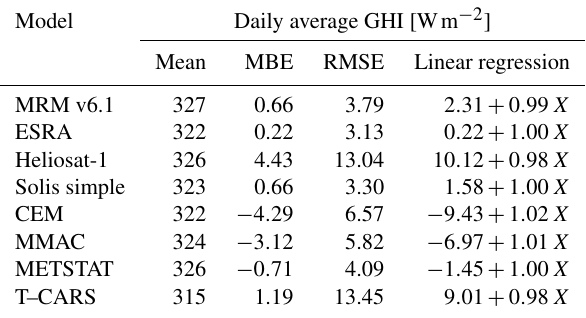
Table 4. Comparison of the annual mean of daily average values of GHI at the surface simulated with each CSM and T–CARS com- pared to DWD observations. Note that the number of days available for comparison varies between models. In addition to MBE, RMSE and correlation ( R ), the linear regression function is shown with ref- erence irradiance measured by DWD denoted as X . The correlation of retrieval and observation is always larger than